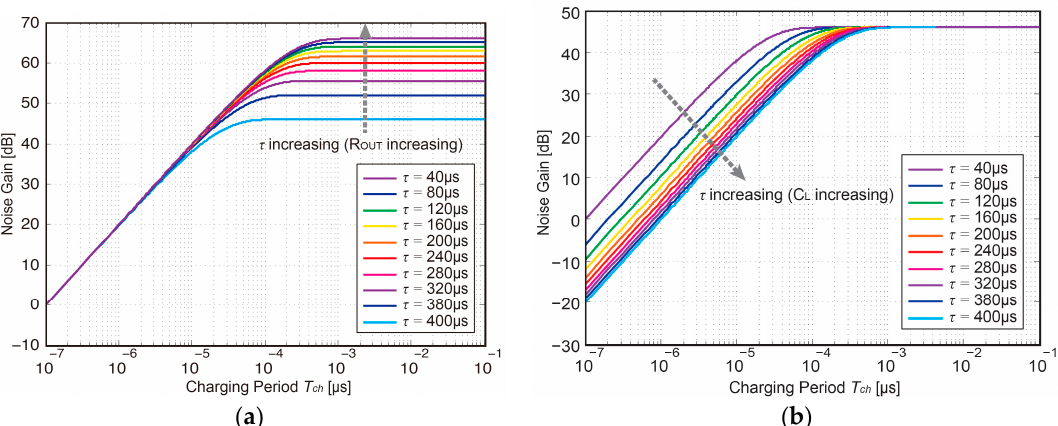
Figure 7. Noise gain factor as a function of charging period T ch ( a ) with τ and R OUT increasing ( b ) with τ and C L increasing.